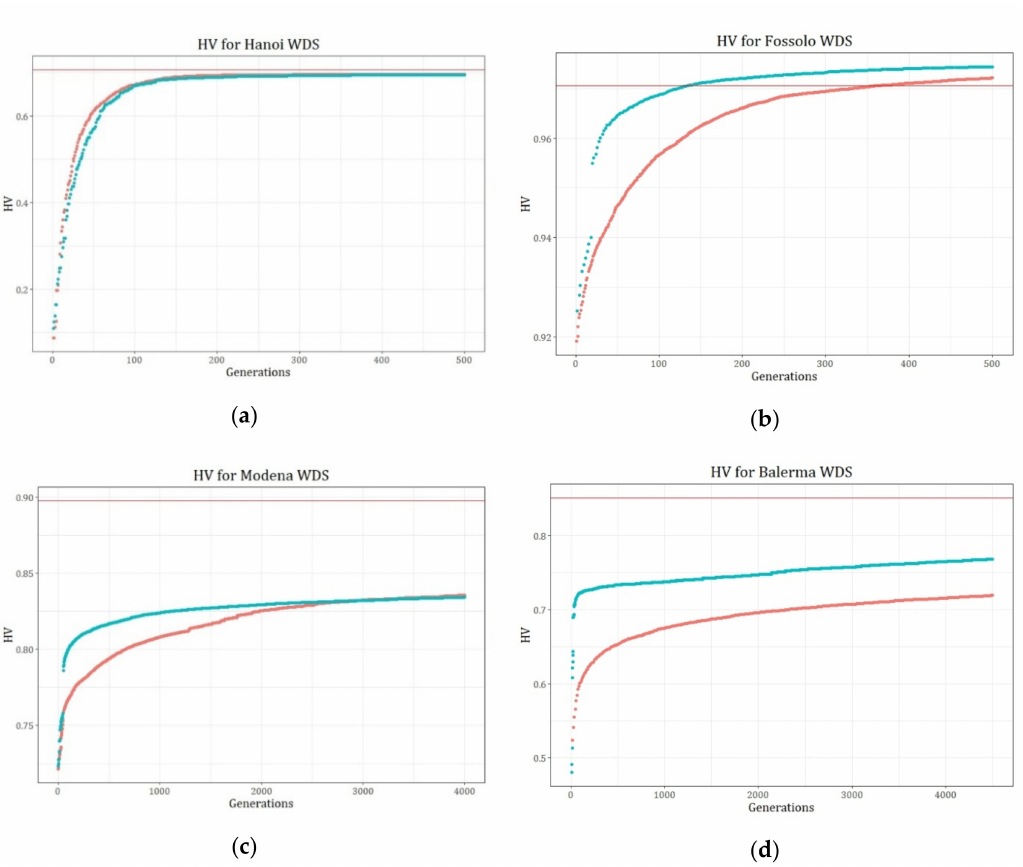
Figure 6. Evolution of the hypervolume (HV) for assessing the results of the NSGA-II algorithm (red) and the retrofitted NSGA-II with OPUS (green) in comparison to the hypervolume (HV) best-known PF (continuous red line) for tested networks. ( a ) Hanoi; ( b ) Fossolo; ( c ) Modena and ( d )